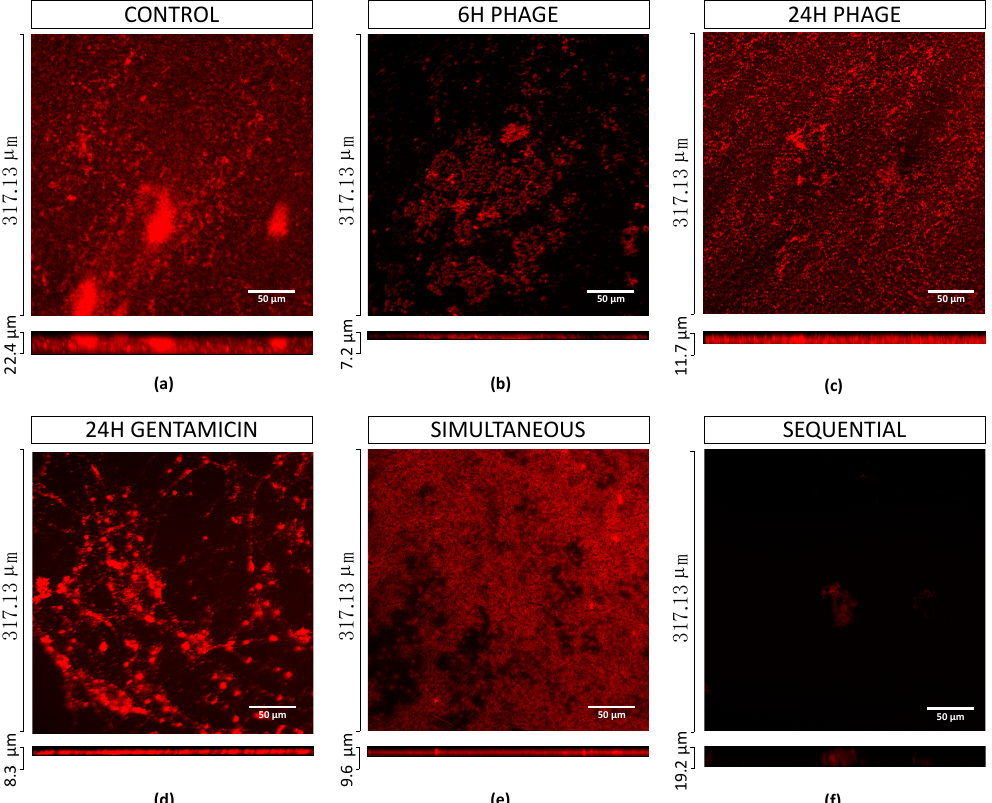
Figure 3. 3D reconstructions of confocal stacks of images of mono-species P. aeruginosa biofilms. ( a ) Control, ( b ) 6 h phage treatment, ( c ) 24 h phage treatment, ( d ) 24 h Gentamicin treatment, ( e ) 24 h simultaneous treatment, ( f ) 24 h sequential treatment. All biofilms were stained with EPA1_TFP (with mCherry) recombinant protein. Scale bar represents 50 μ m.